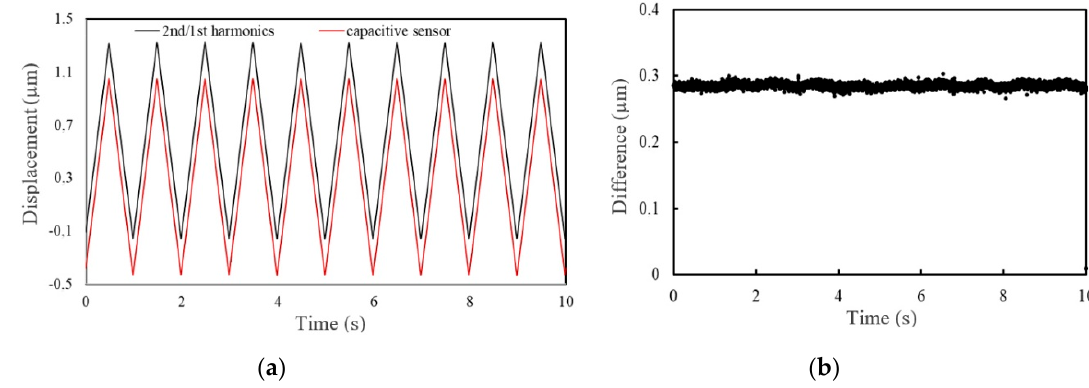
Figure 7. First and second harmonics detected by the lock-in amplifiers (LIAs) ( a ) and illustrated in a Lissajous diagram ( b ).